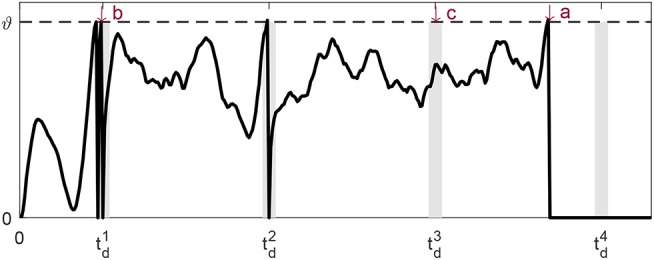
Three error types: undesired spike outside the tolerable window (a), undesired spike inside the tolerable window (b) and missed spike within the tolerable window (c). The gray vertical bars near the desired spike times tdj are the respective tolerable windows.